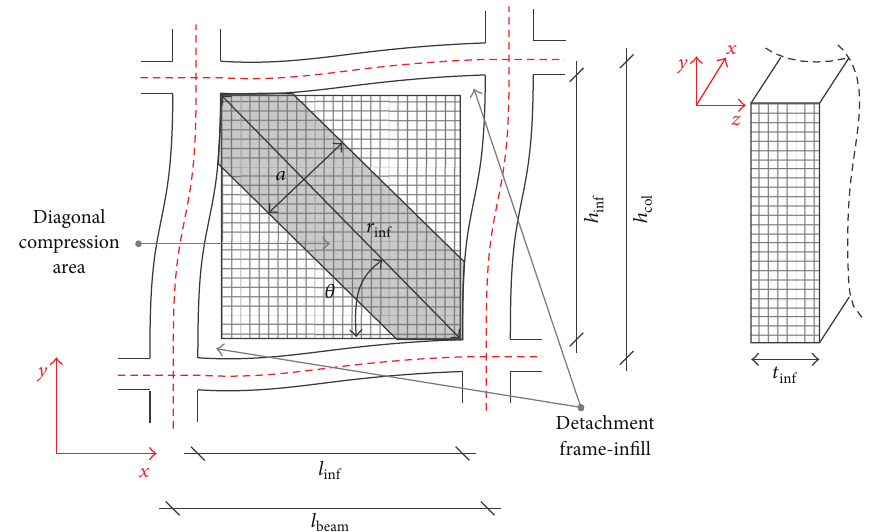
Figure 6: Macromodeling of the infill panel based on the equivalent strut